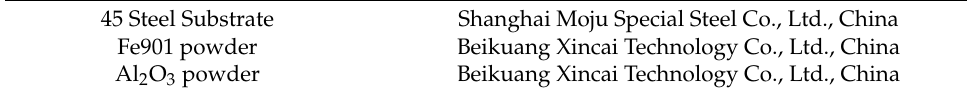
Table 3. Commercial sources for the raw